Question: What does this figure show? Answer in one sentence.
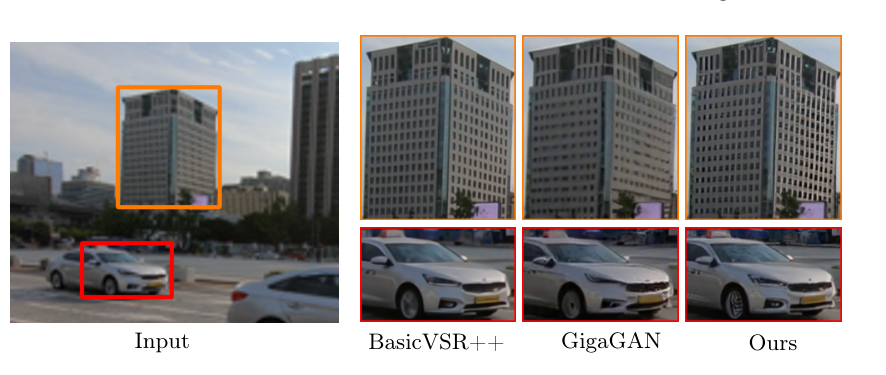
Answer: Limitations of previous methods. Previous VSR approaches such as BasicVSR++ [7] suffer from lack of details, as seen from the car example. Image GigaGAN produces sharper results with richer details, but it generates videos with temporal flickering and artifacts like aliasing (see building). Our VideoGigaGAN can produce video results with both high-frequency details and temporal consistency while artifacts like aliasing are significantly mitigated.